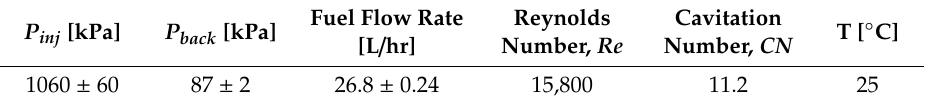
Figure 1. Nozzle geometry used for the experiment by Duke et al. [15] (Reproduced with permission). Table 1. Operating conditions of the experiment